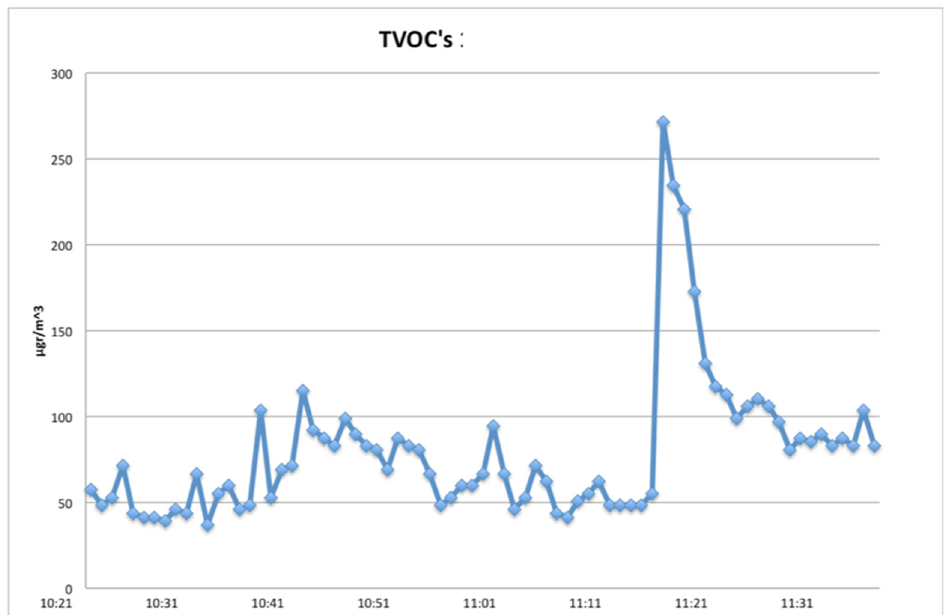
Figure 7. TVOCs on D18. Windows were open and Er:YAG Laser was in use from 11:10 to 11:30 (1-h recording).